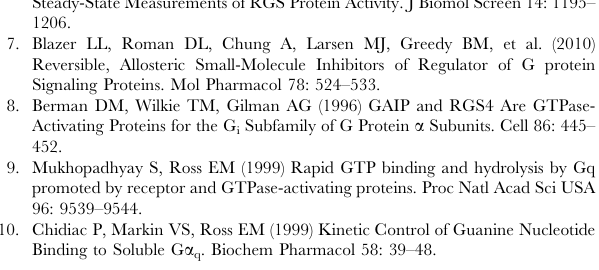
Figure S1 Wavelength Scan of 10 m M Na 3 PO 4 . Using 10 m M Na 3 PO 4 as a control, a wavelength scan of the absorbance of the system was evaluated to determine the optimal wavelength for detection. Two peaks were detected with local maxima at 436 nm and 642 nm. (TIFF) Figure S2 Peak Evaluation. The two selected peaks, 642 nm and 436 nm, were evaluated using K dilutions of Na 3 PO 4 from 50 m M to 0.4 m M. The peak at 642 nm had a three fold greater response to Na 3 PO 4 than the peak at 436 nm at equivalent concentrations.